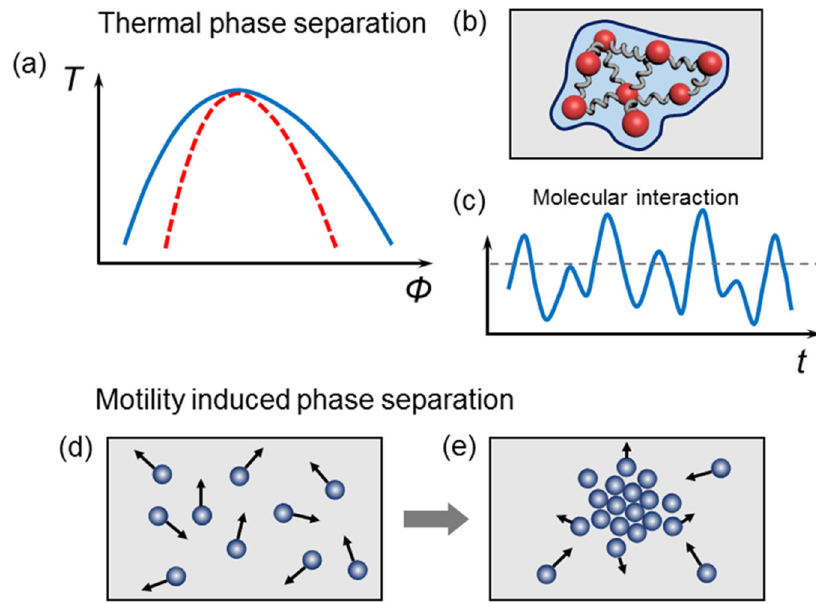
Fig. 1 Deconstructing phase separation — old and new. a The traditional liquid-liquid phase diagram, sketched here with axes of temperature and volume fraction, is controlled by thermodynamic variables only. This concept led in the 19th and early 20th century to use strategies to control items such as materials microstructure, and to intellectual inquiry such as why oil fl oats on soup, all of this based on nucleation and growth corresponding to deep quenches below the binodal (solid blue) line 3 . Then came a surprise — the identi fi cation of spinodal decomposition (dotted red line) 4 . b In modern times, Tanaka and coworkers 1,6 have demonstrated the novelty of thermal phase separation when the phase-separating components respond over drastically different response times, shown here schematically as viscoelasticity resulting from time-dependent elastic (red) interactions in the viscous (blue) liquid. c Other modern work toggles molecular interactions themselves during the course of phase separation, shown here schematically as modulation in time. d Out-of-equilibrium active matter systems present radically different situations. These active, motile particles have directional motion because they consume energy, shown here schematically as arrows on the moving particles. e States of motility-induced phase separation, controlled by differential motility of individual active particles, can result. The regions of high-density form because moving objects tend to accumulate where they move more slowly. Here the differential arrow lengths denote differential